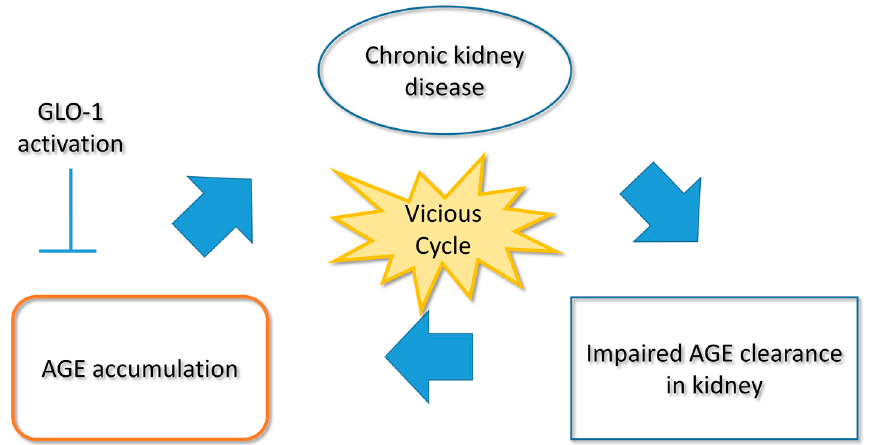
Figure 1. Vicious cycle between CKD and glycative stress. In CKD patients, renal AGE clearance is insufficient because of the low glomerular filtration rate and GLO-1 inhibition. This is followed by AGE accumulation. AGEs themselves have been confirmed to have nephrotoxicity. Thus, CKD and AGE accumulation constitutes a vicious cycle. Abbreviations: AGEs, advanced glycation end products; CKD, chronic kidney disease; GLO-1, glyoxalase 1.